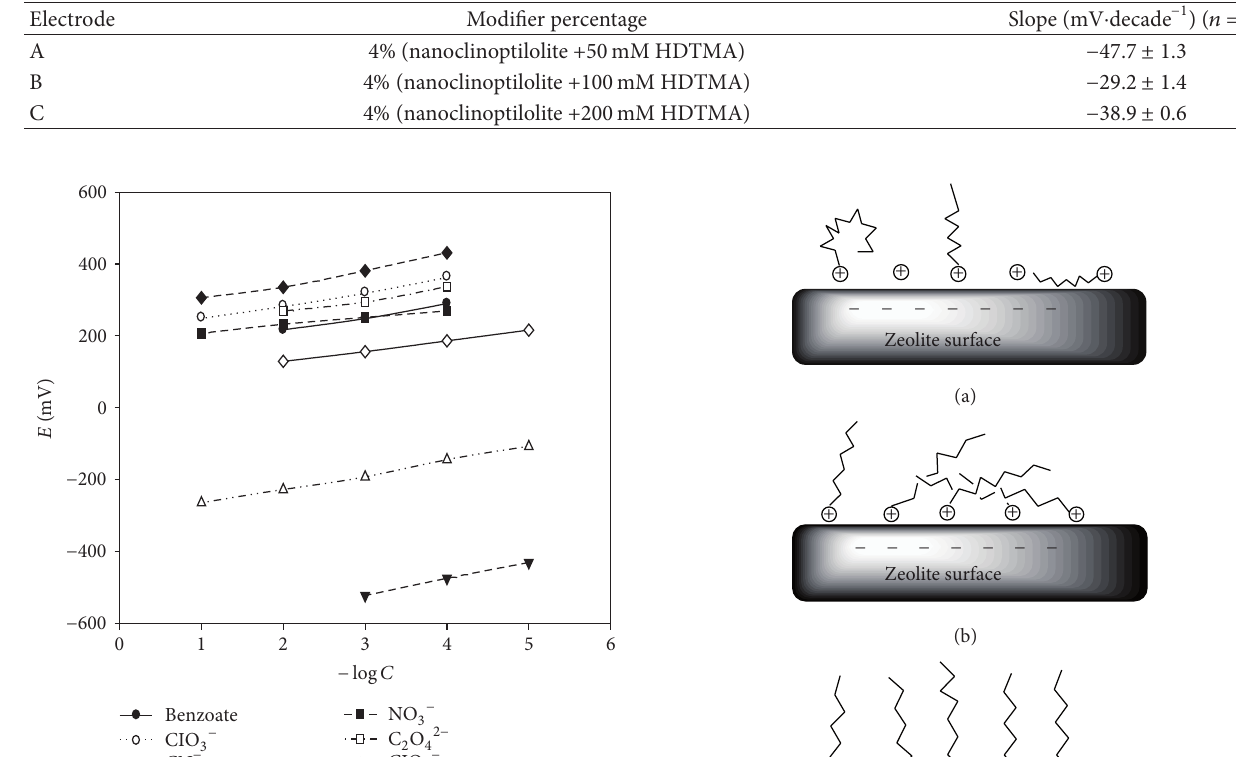
T 2: Optimization of the modi�er percentage in chromate-selective electrode based on SMZ at 25